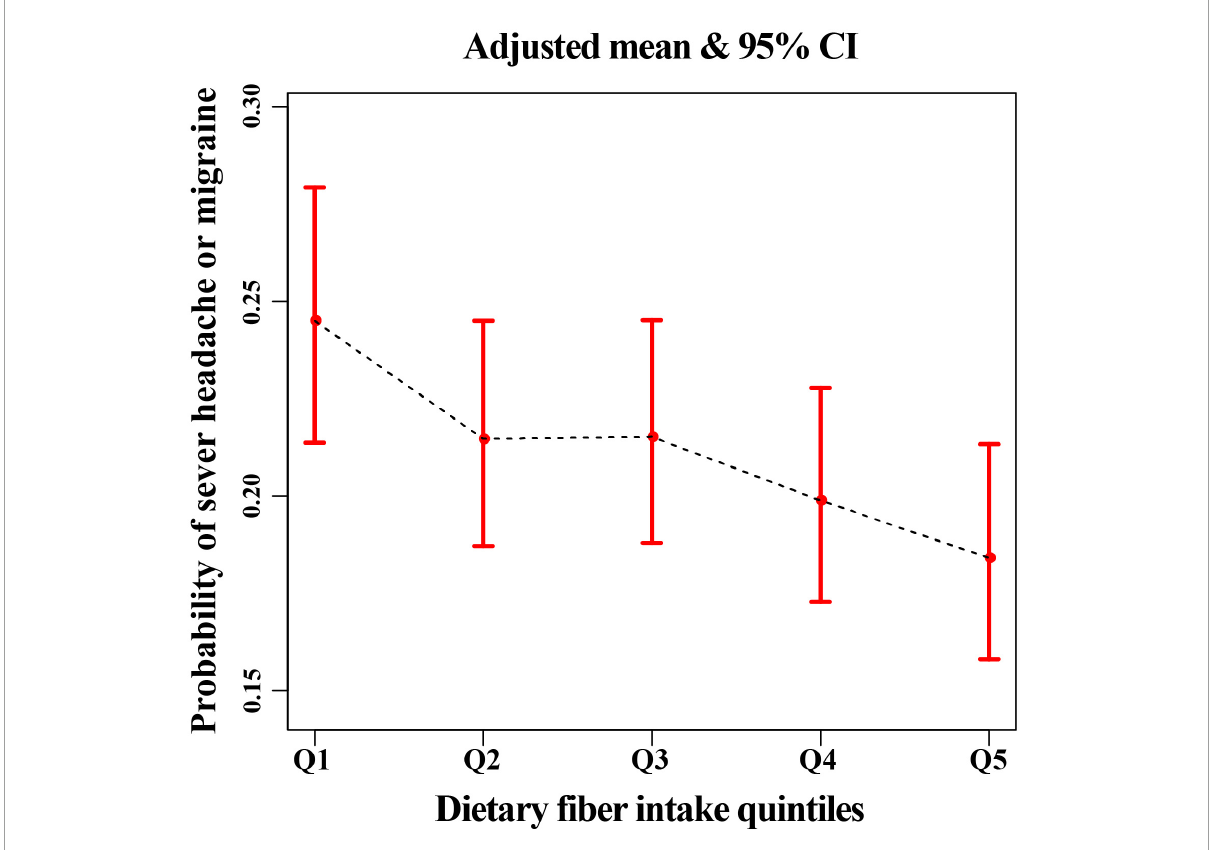
FIGURE2 The relationship between headache or migraine with dietary fiber quintiles after adjusting all related covariates in this study.